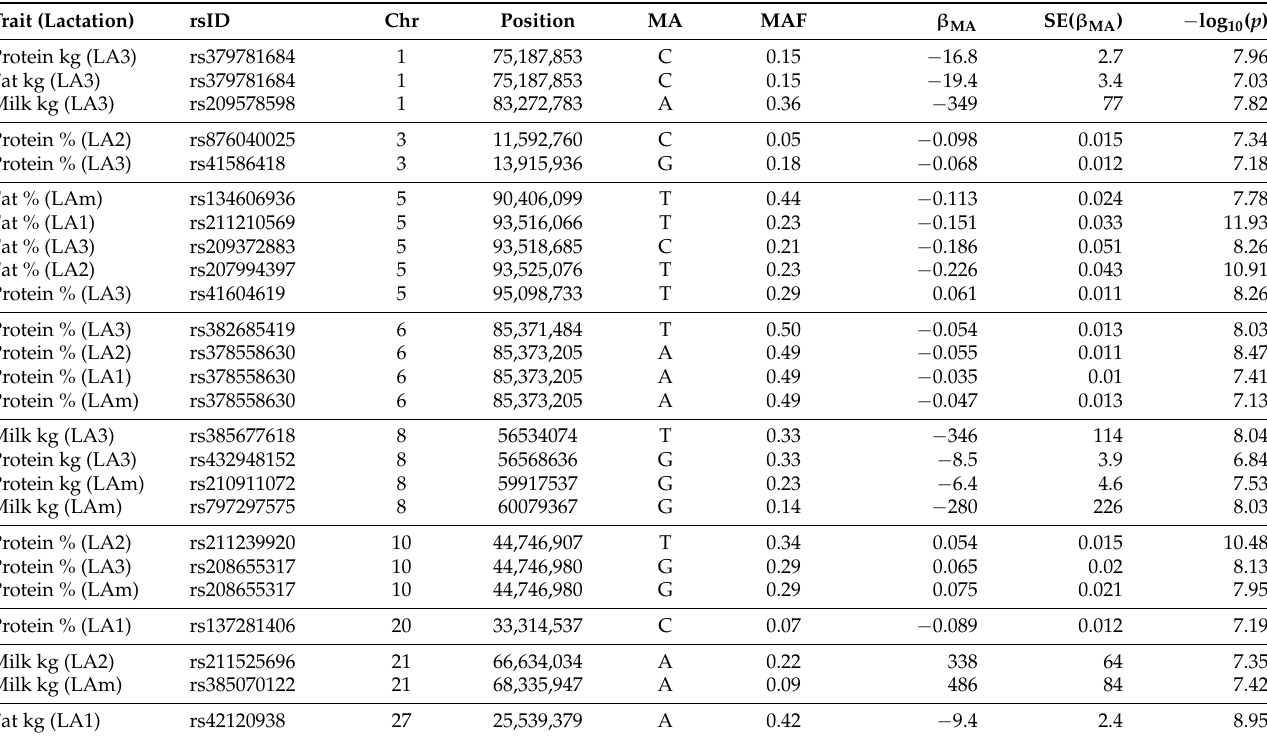
Table 1. Top SNPs associated with milk production traits in DSN cows. For each investigated trait, associated SNPs (rsID) are listed with chromosomal (Chr) positions (Position) with regard to the ARS-UCD1.2 genome assembly. MA = minor allele, MAF = minor allele frequency, β MA = allele substitution effect of MA and its standard error (SE). Test statistics with − log 10 ( p ) ≥ 6.8, ≥ 7.1 and ≥ 7.8 were suggestive, significant and highly significant,